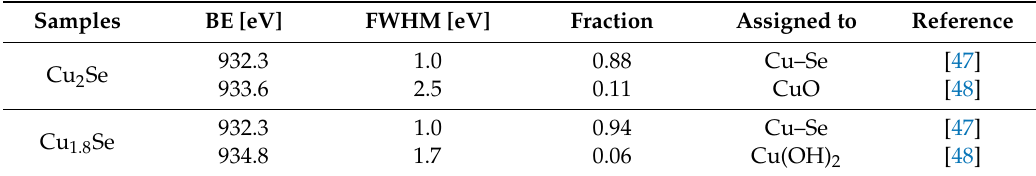
Table 2. XPS peak fitting results for Cu 2p 3 / 2 region for SPS sintered bulk samples.